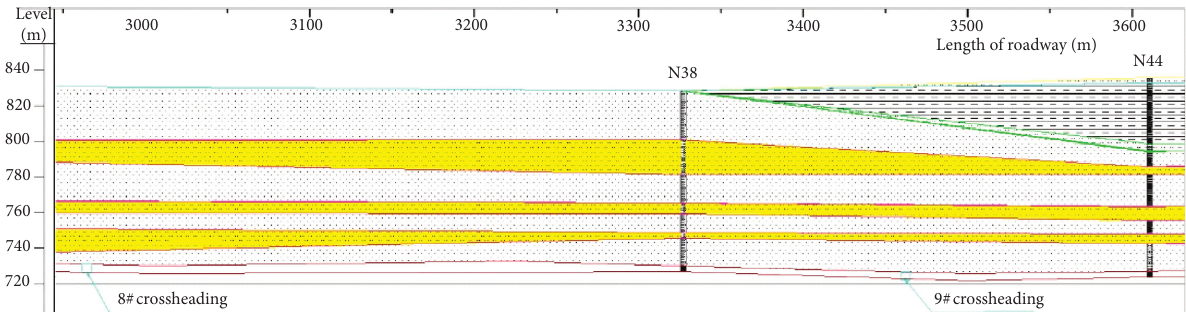
Figure 5: Regional section of roof